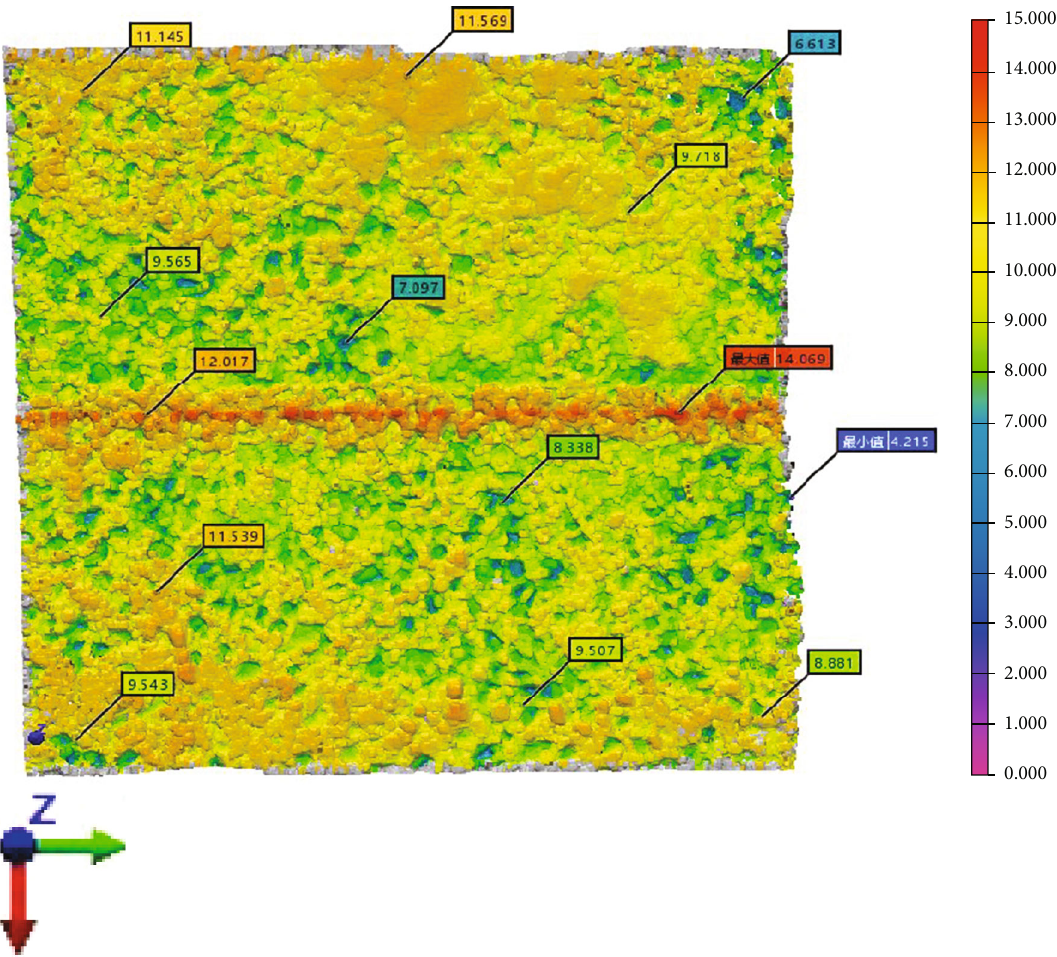
Figure 7: Overall thickness distribution cloud diagram of bridge deck with welded joint.